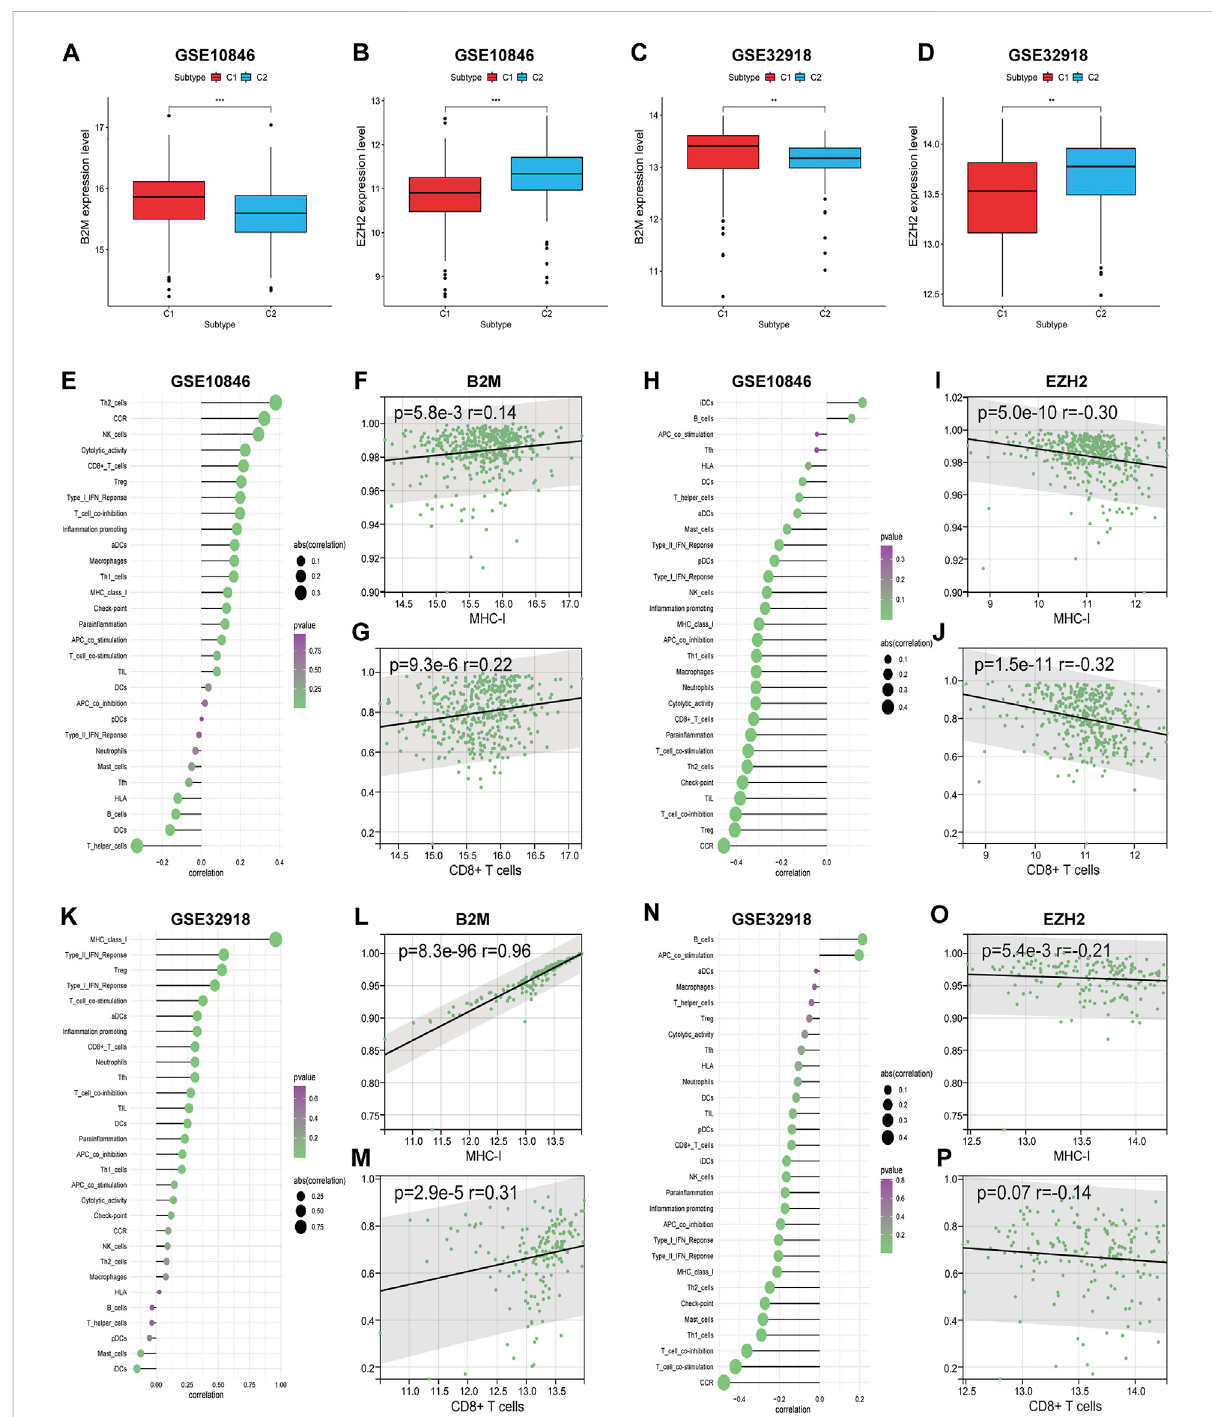
FIGURE 6 The correlations between the expression levels of two genes ( B2M and EZH2 ) and DLBCL immune microenvironment. (A – D) The expression differencesoftwogenesbetweenthetwosubtypes. (E,K) Thecorrelations between B2M andimmunecellcontents. (H,N) Thecorrelationsbetween EZH2 and immune cell contents. (F,G) (L,M) The correlations between B2M and MHC-I, CD8 + T cells, respectively. (I,J) (O,P) The correlations between EZH2 and MHC-I, CD8 + T cells, respectively. Wilcoxon test was used to compare gene expression levels between the two